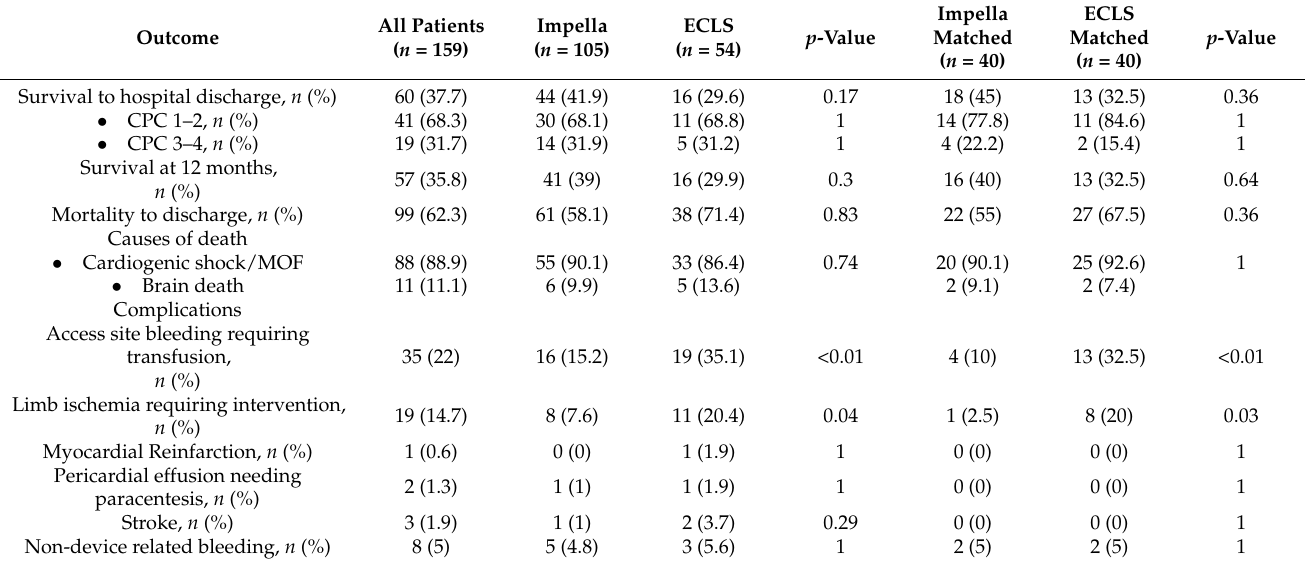
Table 3. Clinical outcomes and